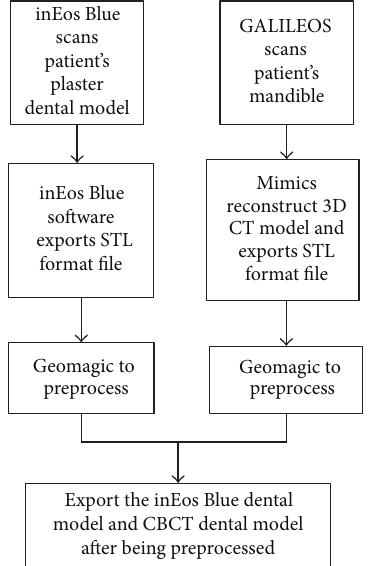
Figure 3: The flow chart of data acquisition and preprocess.